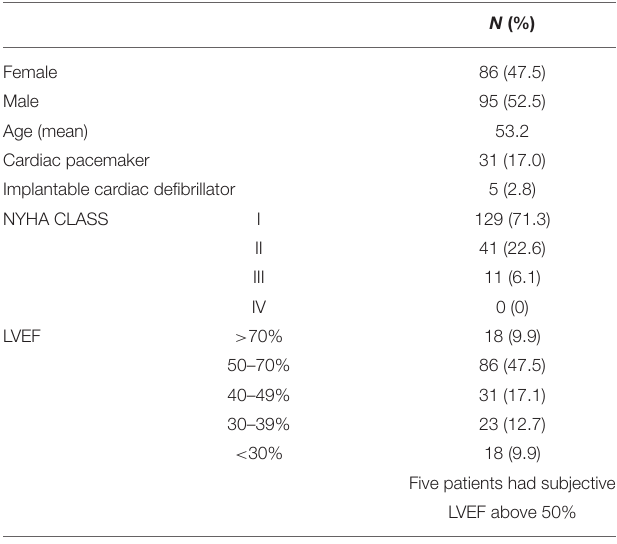
TABLE 2 | Clinical and laboratory parameters of 181 chronic Chagas cardiomyopathy